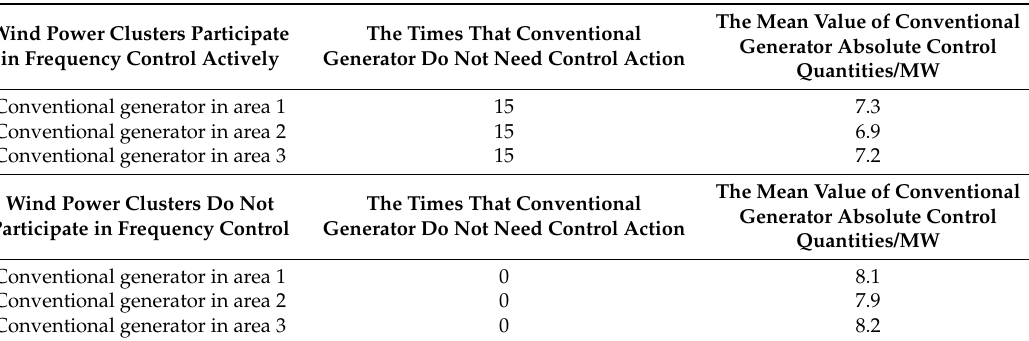
Table 5. Operation cost